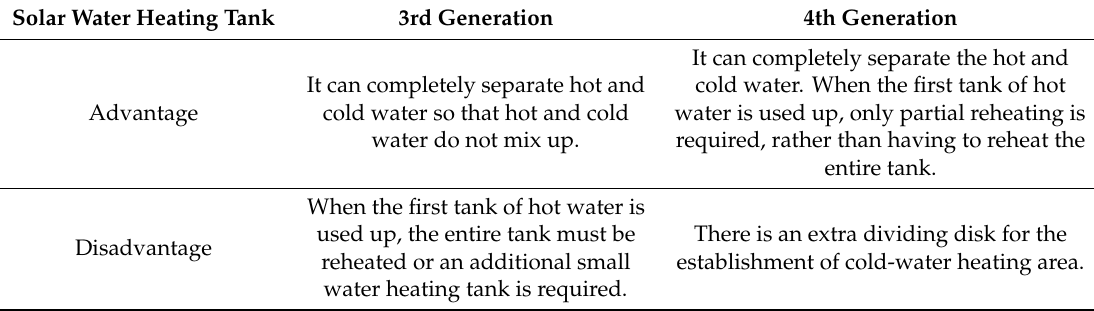
Table 4. Comparison of 3rd and 4th generation solar water heating